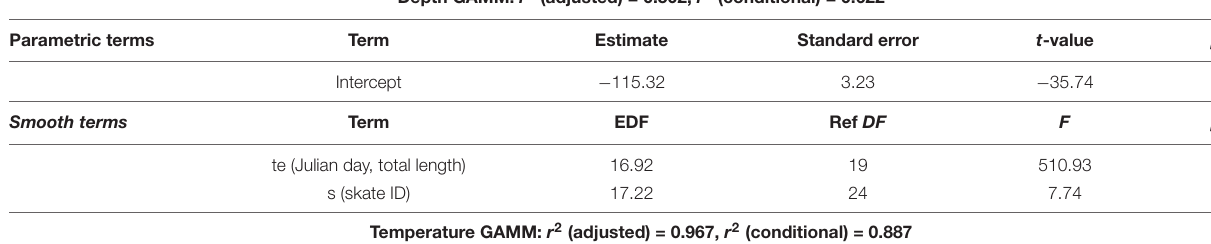
TABLE 2 | Coefficients from GAMMs of depth and